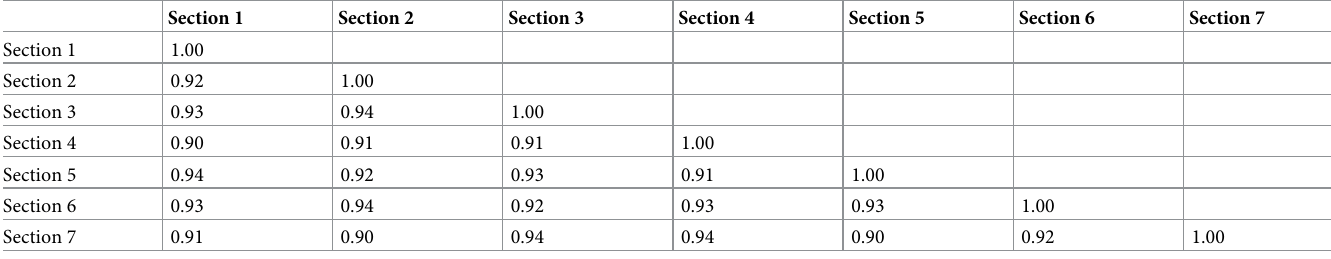
Table 1. Average score correlations across all